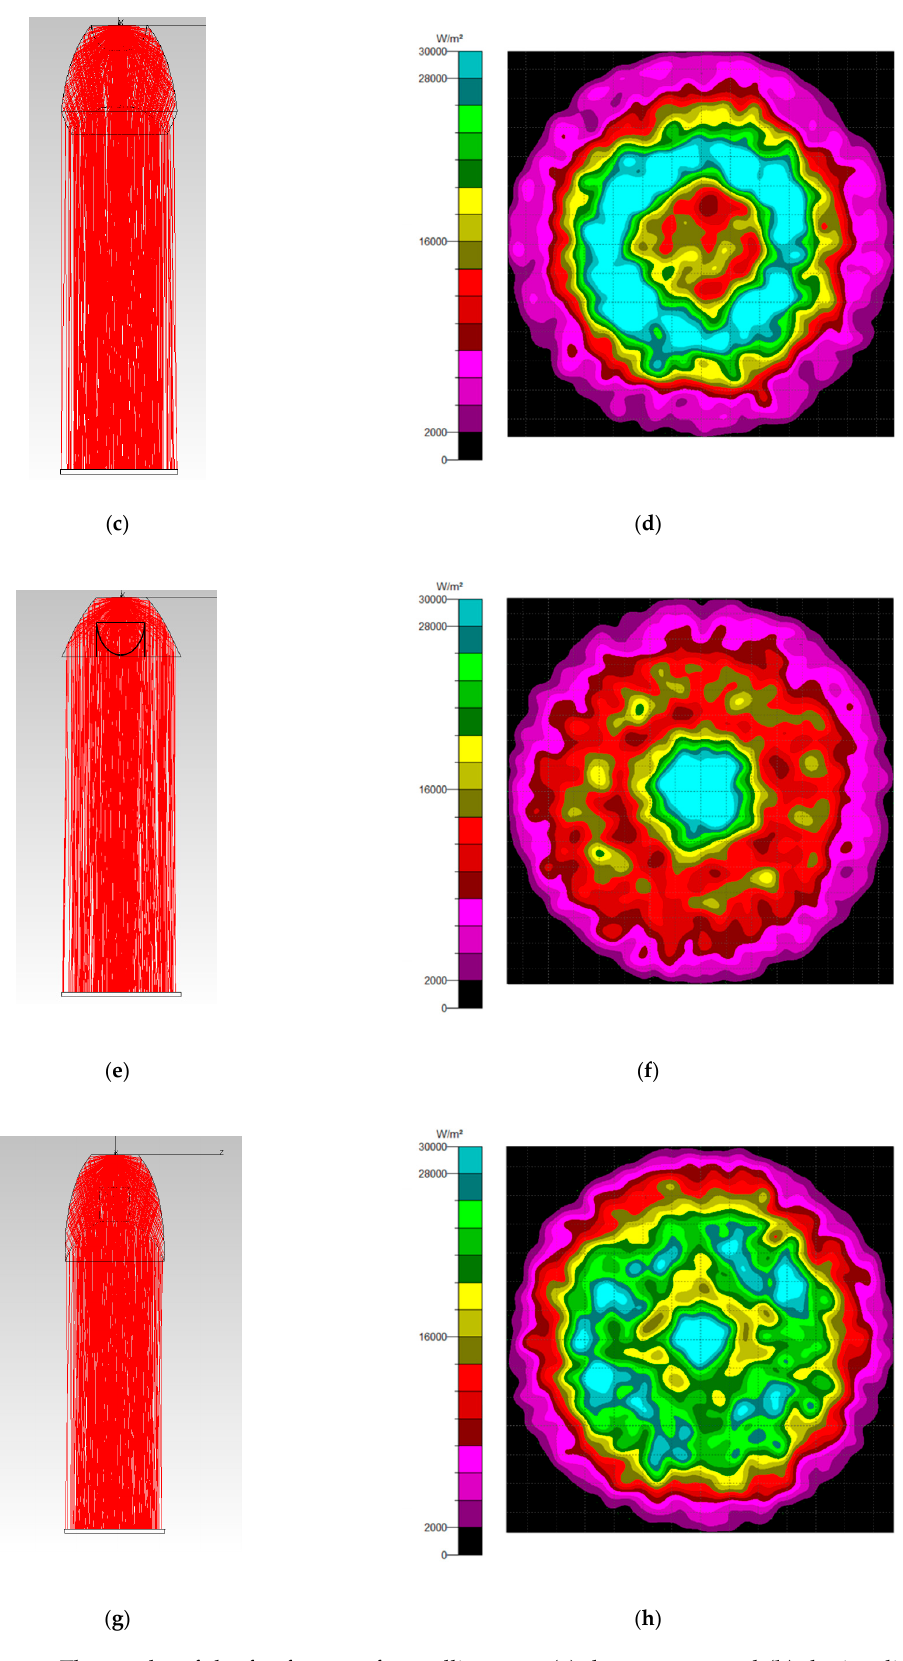
Figure 17. The results of the freeform surface collimators: ( a ) the ray trace and ( b ) the irradiance distribution of the TIR collimator; ( c ) the ray trace and ( d ) the irradiance distribution of the elliptical collimator; ( e ) the ray trace and ( f ) the irradiance distribution of the new TIR collimator; ( g ) the ray trace and ( h ) the irradiance distribution of the new elliptical